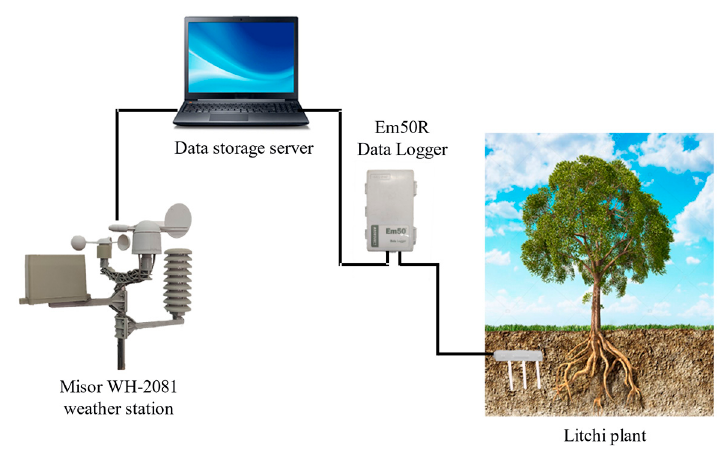
Figure 2. The weather station and soil moisture sensor to collect data.